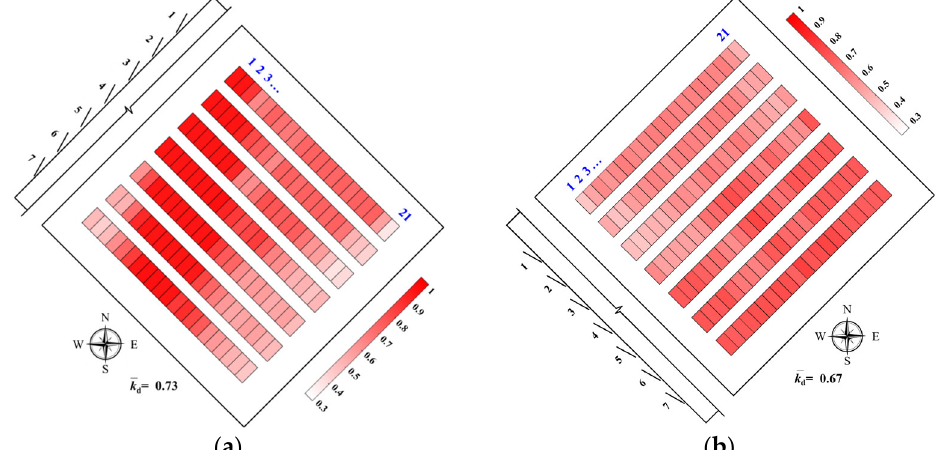
Figure 11. Distributions of directionality factor k d for solar arrays installed in Jinan, China, with different building orientations: ( a ) α = 45°; ( b ) α = − 45°.